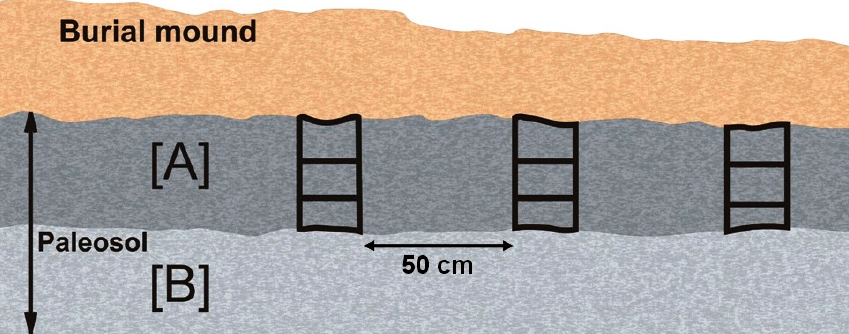
Figure 2. The scheme of paleosol humus horizon sampling.